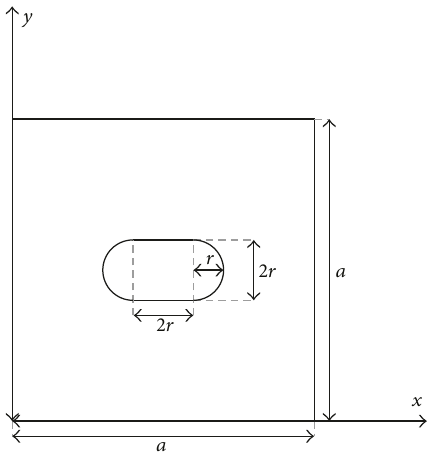
Figure 11: Square plate of size 𝑎 × 𝑎 and thickness ℎ with a hole located in the center of the